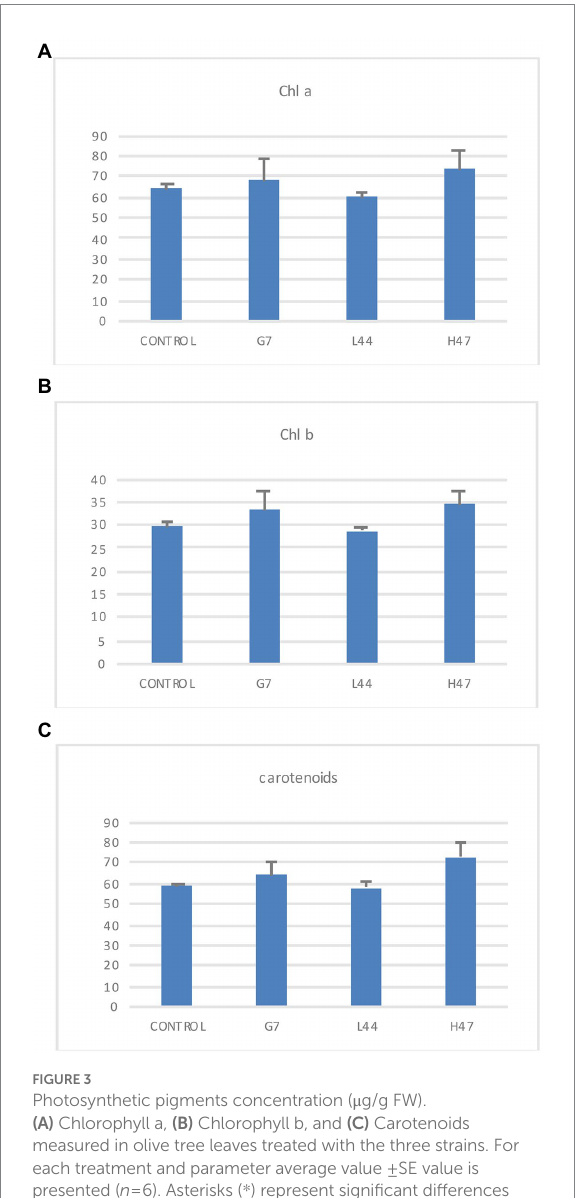
FIGURE 2 Photosynthetic parameters related to C fixation measured in olive tree plants treated with the three strains and non-inoculated controls. (A) Net photosynthesis (Pn) measured as the CO 2 fixed by the leaves ( μ mol CO 2 /m 2 s). (B) Transpiration rate (E), measured as the amount of water released by transpiration ( μ mol H 2 O/m 2 s), and (C) Water Use Efficiency (WUE) calculated as Pn divided by transpiration rate. Average values of the replicates with SE bars are represented ( n = 6). Asterisks ( * ) represent significant differences with the control according to T student test ( p < 0.05).